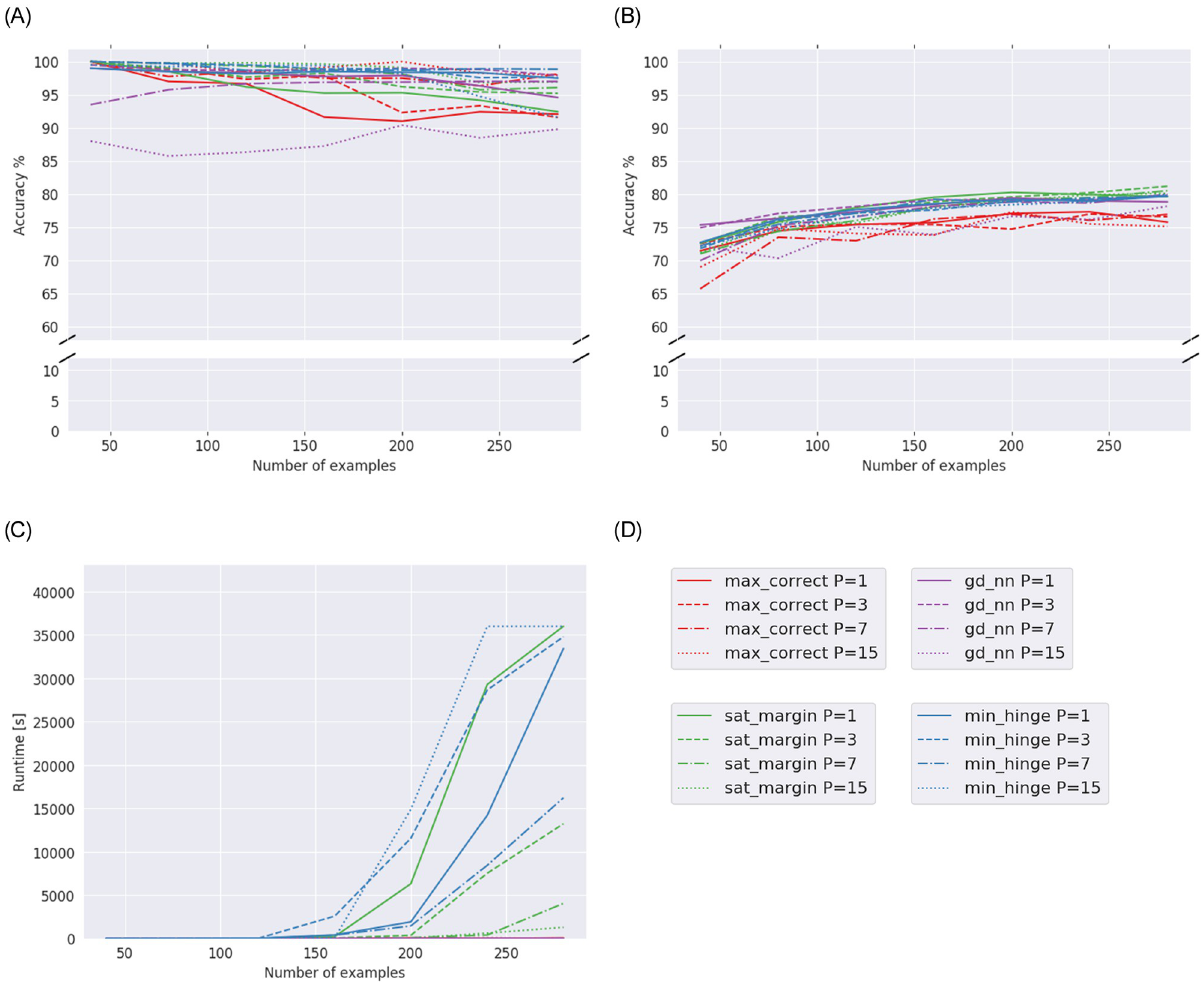
Fig 1. Results for Experiment 2A (Adult dataset), averages over five runs. (a) Training accuracy of models with different parameter ranges for Adult dataset. (b) Testing accuracy of models with different parameter ranges for Adult dataset. (c) Runtimes of models with different parameter ranges for Adult